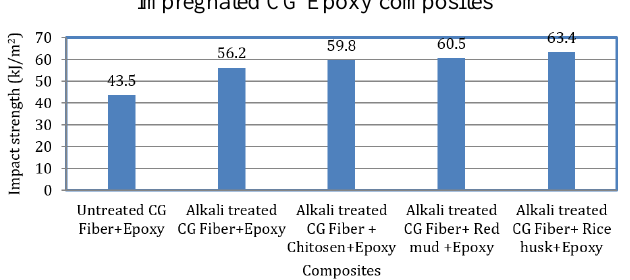
Fig. 5. Tensile failure characteristics of particulates impregnated CG Epoxy composites